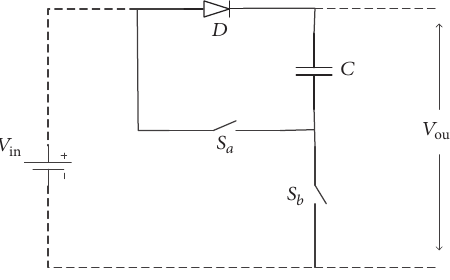
Figure 2: Single unit of switched-capacitor